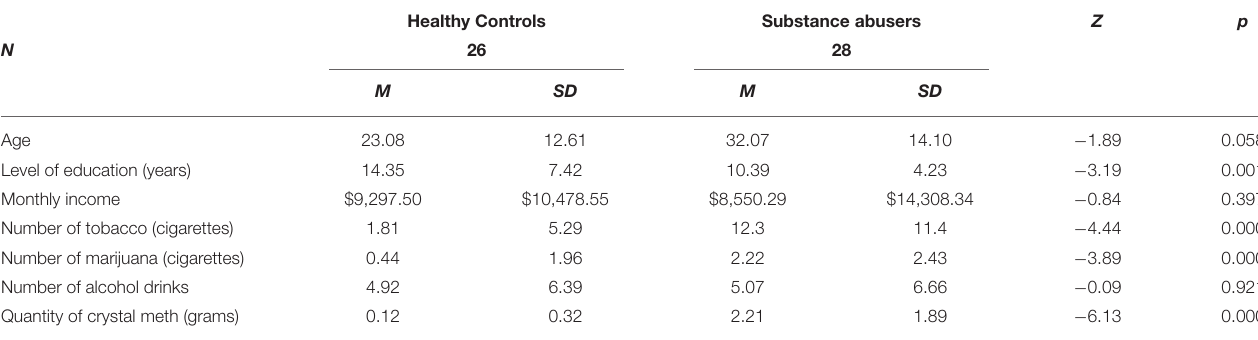
TABLE 1 | Group characteristics.